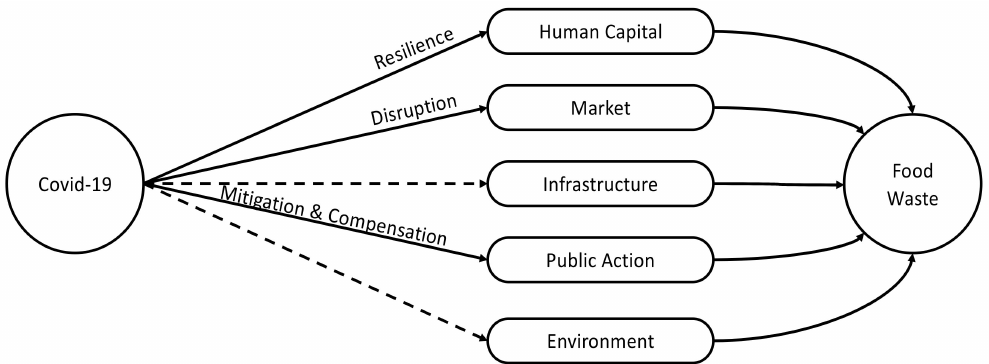
Figure 1. The indirect impact of Covid-19 pandemic on food